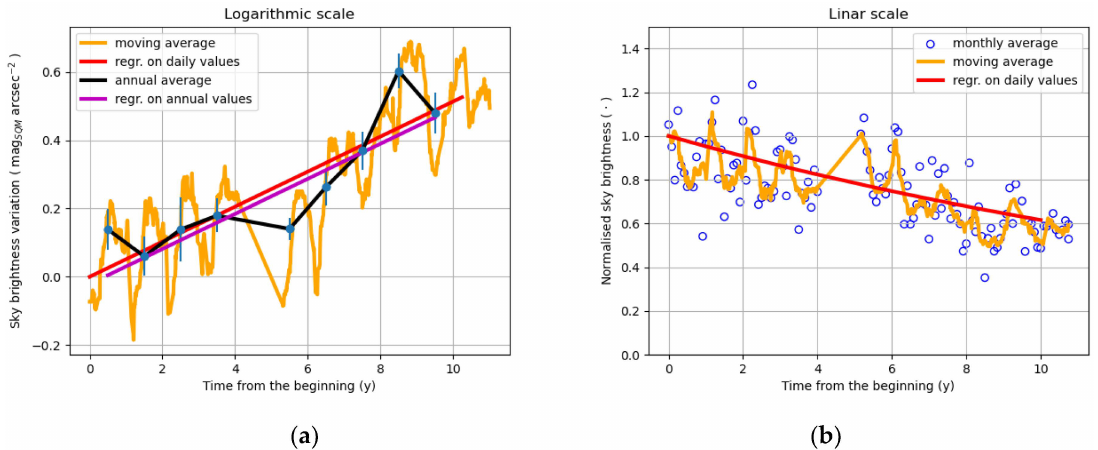
Figure 13. Variation of the sky brightness at Ekar site at twilight due to the instrument ageing and the changing in the atmospheric conditions, in the logarithmic scale ( a ) and in linear scale ( b ). If less regular daily data are available, averaging over a year can allow accounting for slow atmospheric variations loosing seasonal changes and accounting for the instrument ageing, which seems to have a slow trend according to the analysed